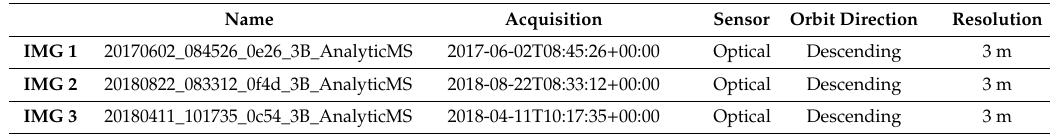
Table 1. Details about the PlanetScope images used in the study.